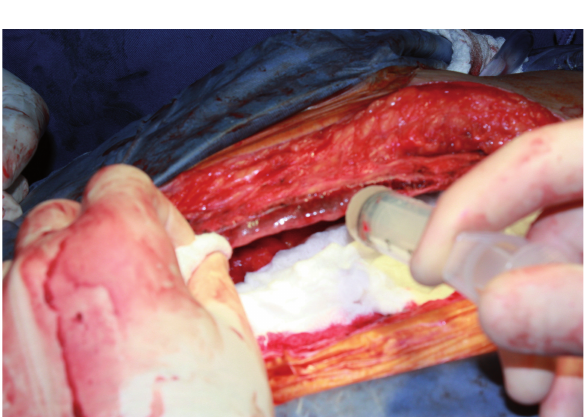
Fig. 2 – Esterno após aplicação do Geli Putty®Fig. 1 – Geli Putty® sendo aplicado ao